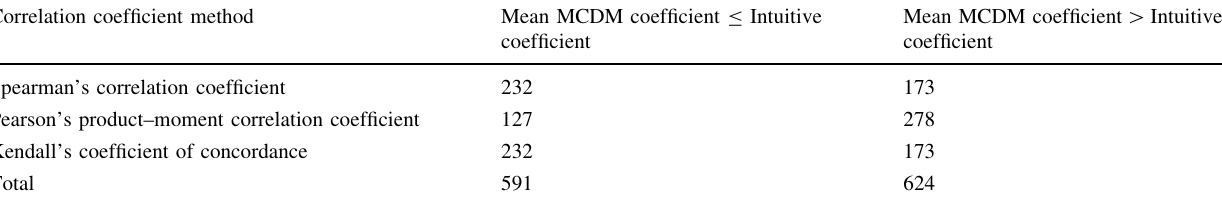
Table 20 Summary of hypothesis 1